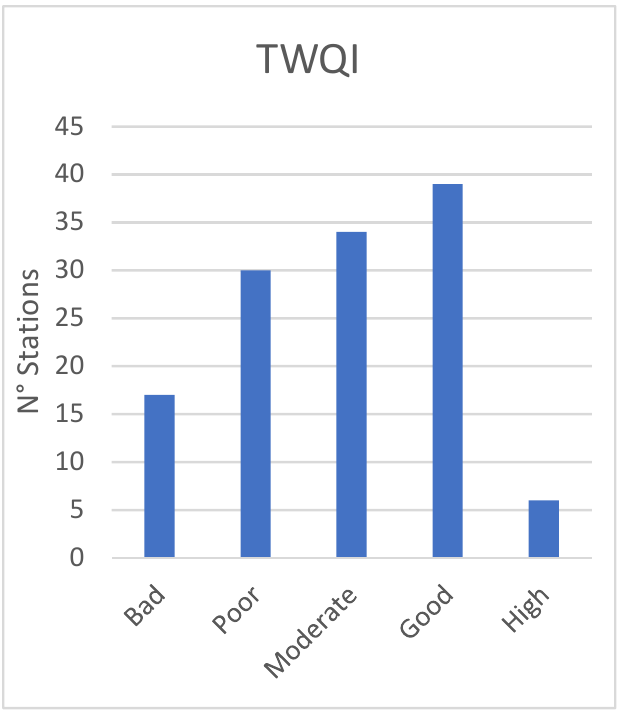
Figure 4. Frequency of distribution of TWQI classes calculated on the dataset (n = 126).